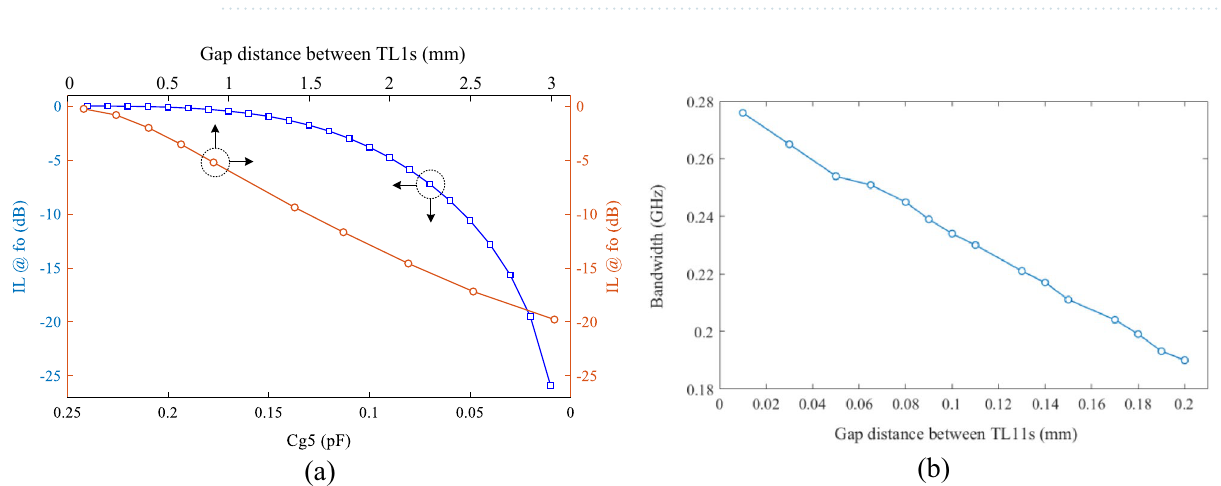
Figure 5. The surface current density at ( a ) TZ1, ( b ) TZ2 and ( c ) f o .